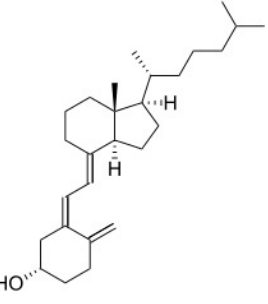
Figure 7. Chemical structure of vitamin D3, cholecalciferol.